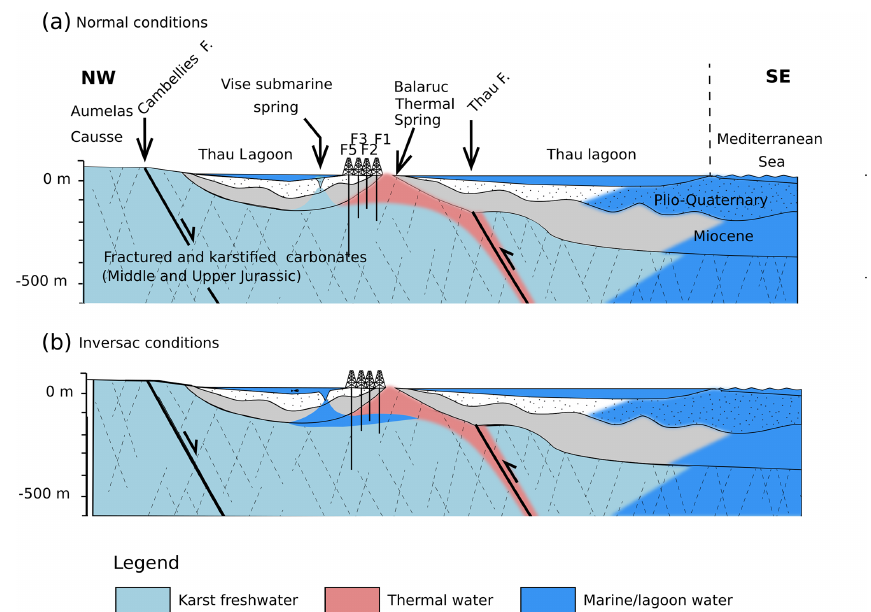
Figure 2. Conceptual cross section oriented NW–SE passing through thermal wells of the Balaruc peninsula and showing groundwater flows of the karst hydrosystem under (a) normal conditions and (b) inversac conditions. Location of the cross section is indicated in Fig. 1a.